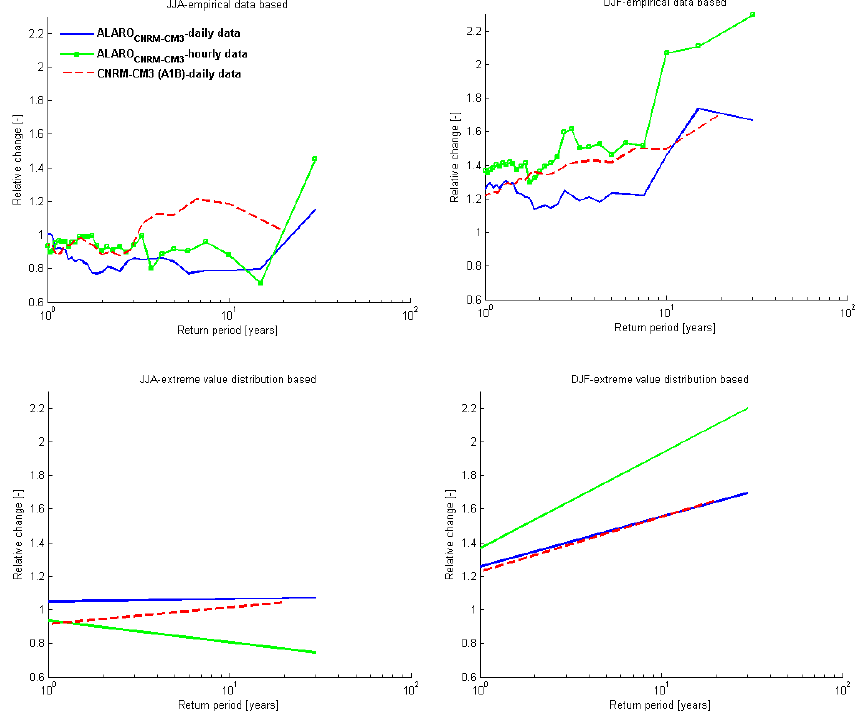
Figure 7. Change factors for daily and hourly precipitation quantiles computed using the ALARO CNRM-CM3 4km and the driving CNRM- CM3 (A1B) for the summer (left-column panels) and winter (right-column panels) seasons, obtained from the empirical data (top panels) and after use of the extreme value distributions (bottom